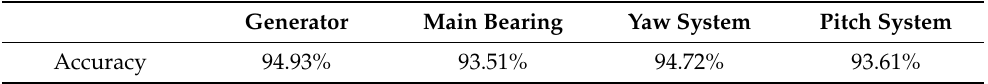
Table 7. Accuracy of the condition diagnosis for each component of the condition monitoring